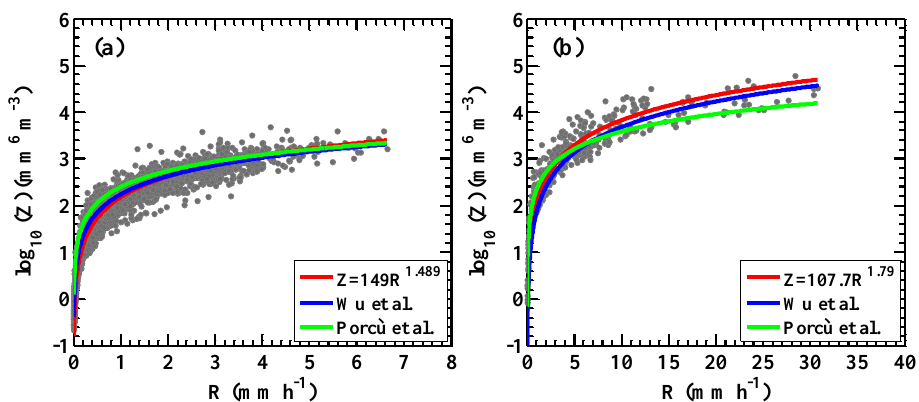
Figure 11. Scatterplots of Z versus R for the stratiform ( a ) and convective ( b ) rains. The blue and red lines are the fitted relationships. The green lines are the results from Wu et al. (2017) [30] and Porcù et al. (2014) [31] for the mid- and southern TP.